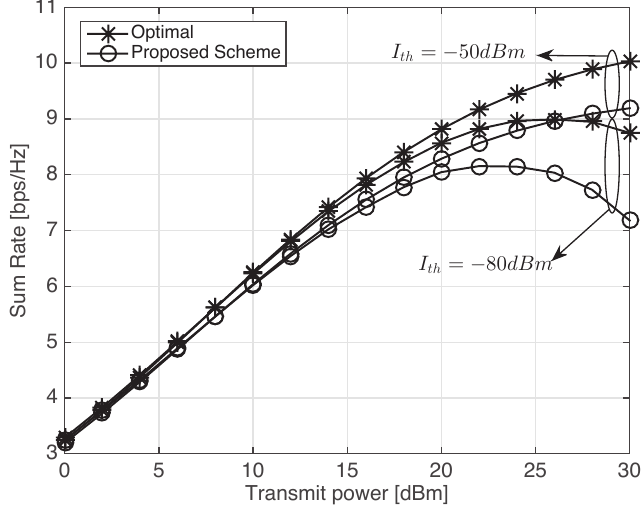
Figure 8. Average sum-rates when all channels are non- i.i.d. and N = 10. Table 2. Average sum-rates when all channels are non-